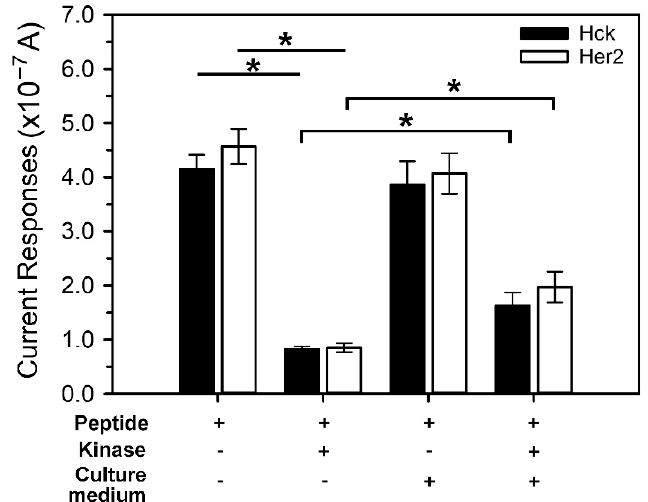
Figure 7. Interference effect of culture medium on the detection of peptides of protein tyrosine kinases. Peptide stock solution and protein kinase stock solution were diluted with the cell culture medium in a ratio of 1:1. The phosphorylation was performed in a kinase reaction mixture containing 10 U/mL of Hck (closed bar) or Her2 (open bar) and 100 μ M ELMO-Y511 (for Hck) or FLT3 (for Her2). The data is mean ± S.D of three independent experiments. (* p < 0.05).